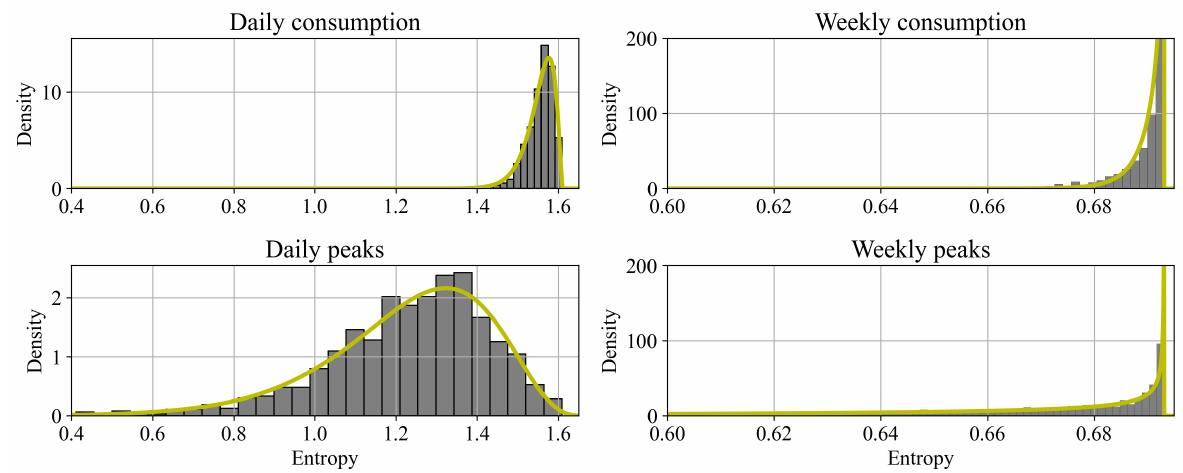
Figure 10. Density histograms of the entropy of the consumption and peak demands at the daily and weekly level, with a fitted beta probability density function overlaid in